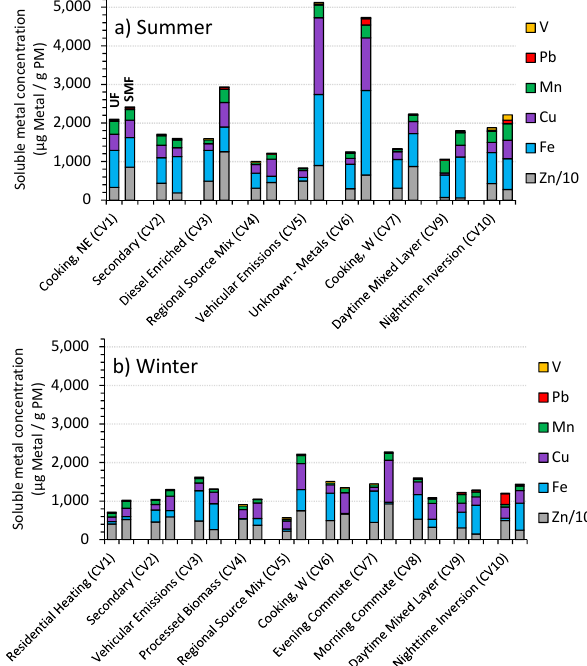
Figure 1. Soluble metal concentrations for (a) summer and (b) win- ter. For each CV, the first bar is the result for the UF size fraction and the second bar is for the SMF size fraction. Zn concentrations are divided by